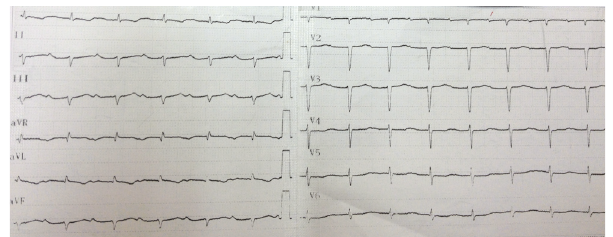
Figure 2: ECG from a patient with cardiac amyloidosis. There are low voltage QRS complexes with left axis deviation and marked 1st- degree atrioventricular block.